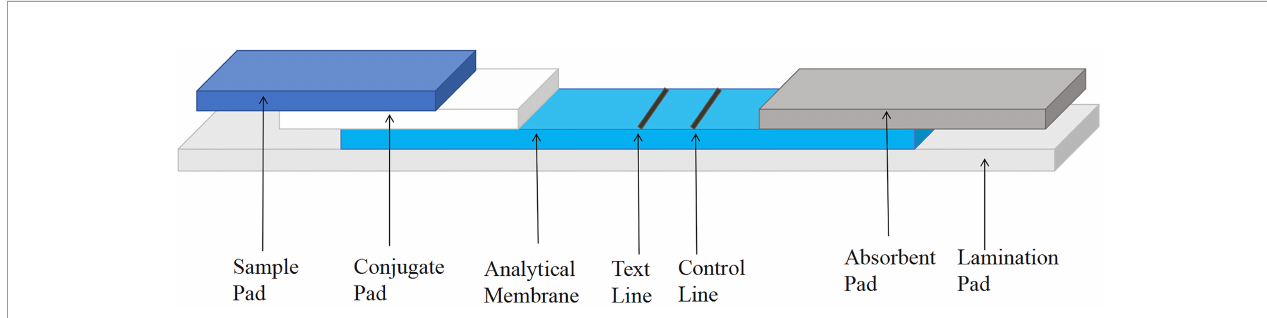
FIGURE 1 | Schematic diagram of the up-converting phosphor technology-based lateral- fl ow (UPT-LF) strip. The sample fl ow direction from sample pad, conjugate pad, analytical membrane to the absorbent pad, which all the structures above are on laminating card. The results were obtained by scanning the test card of the UPT-3A-1200